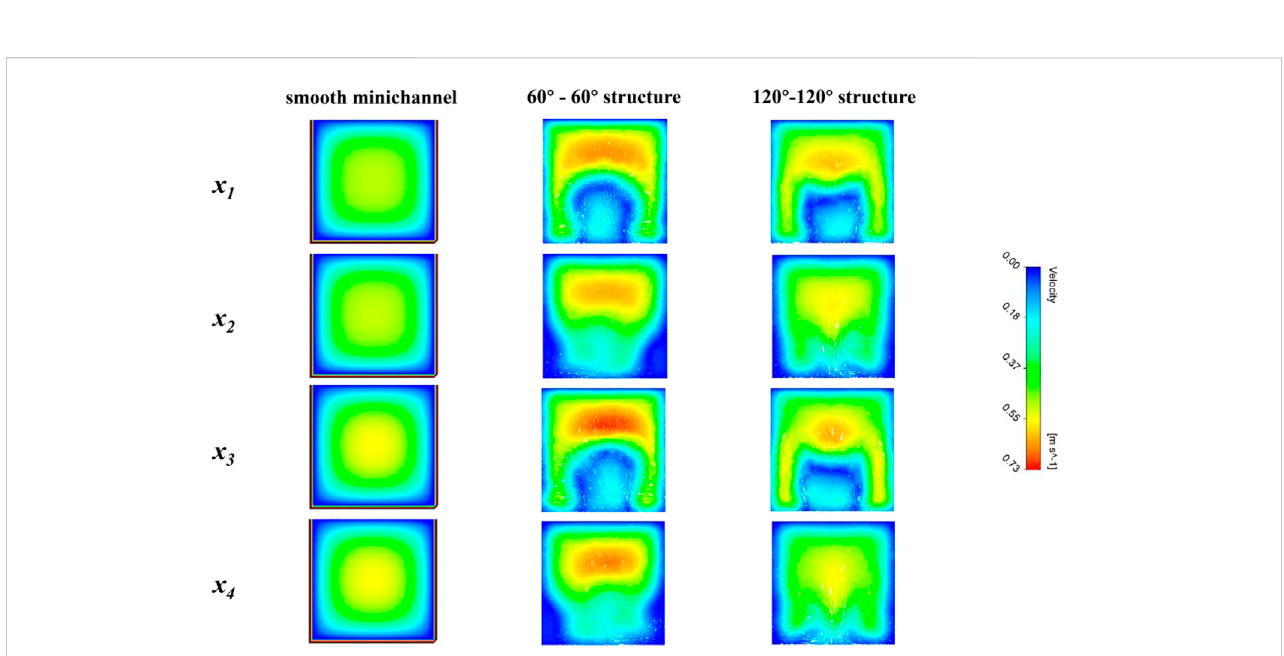
FIGURE 8 Contours ofvelocityondifferentspanwise cross-sectionsfor differentminichannel con fi gurations:x 1 =19mm;x 2 =20.5mm;x 3 =37mm; x 4 =38.5 mm.